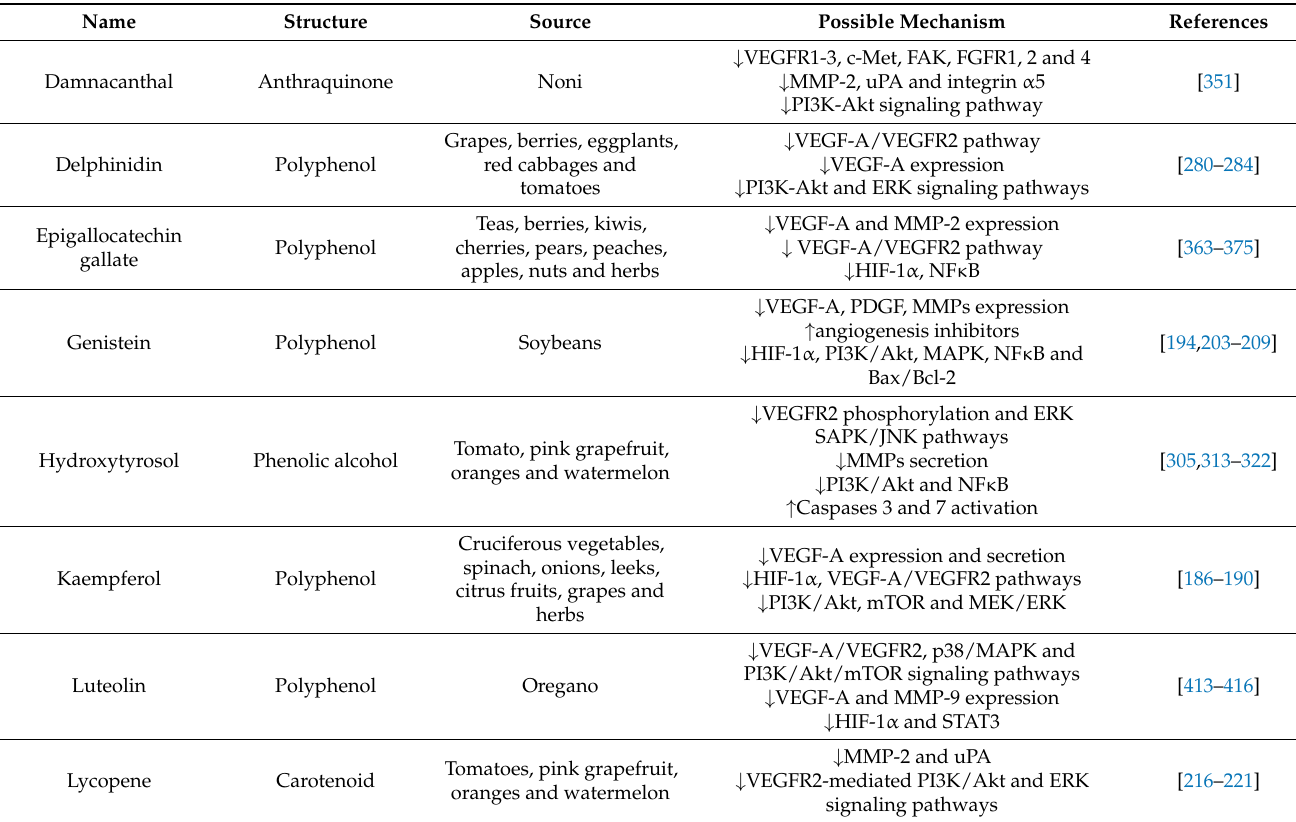
Table 2. Antiangiogenic effect of some selected phytochemicals, mentioned in this